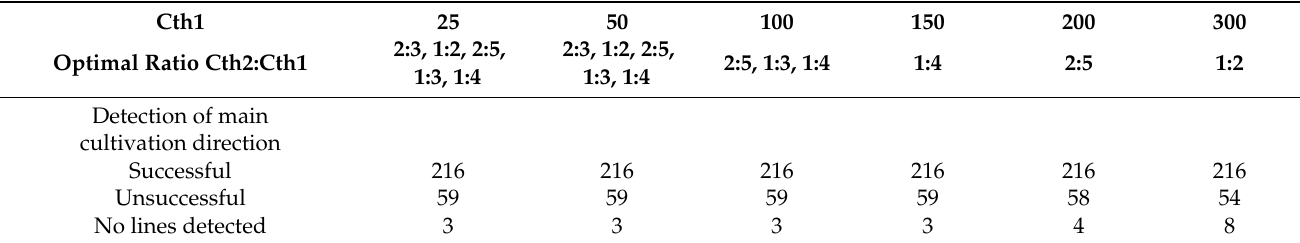
Table 6. Final results for the whole dataset of 278 images with adjusted parameters and different ratios for Canny Threshold parameters.